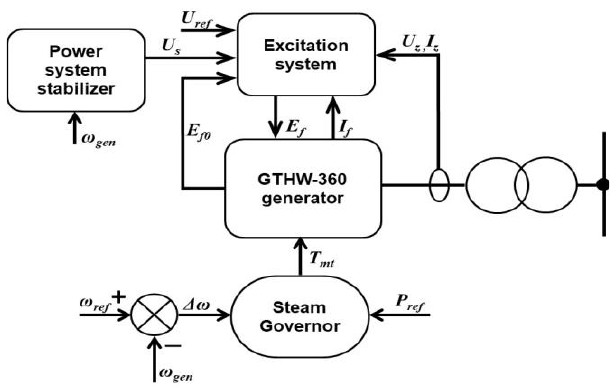
Figure 5. A block diagram of the equivalent turbine-generator unit.